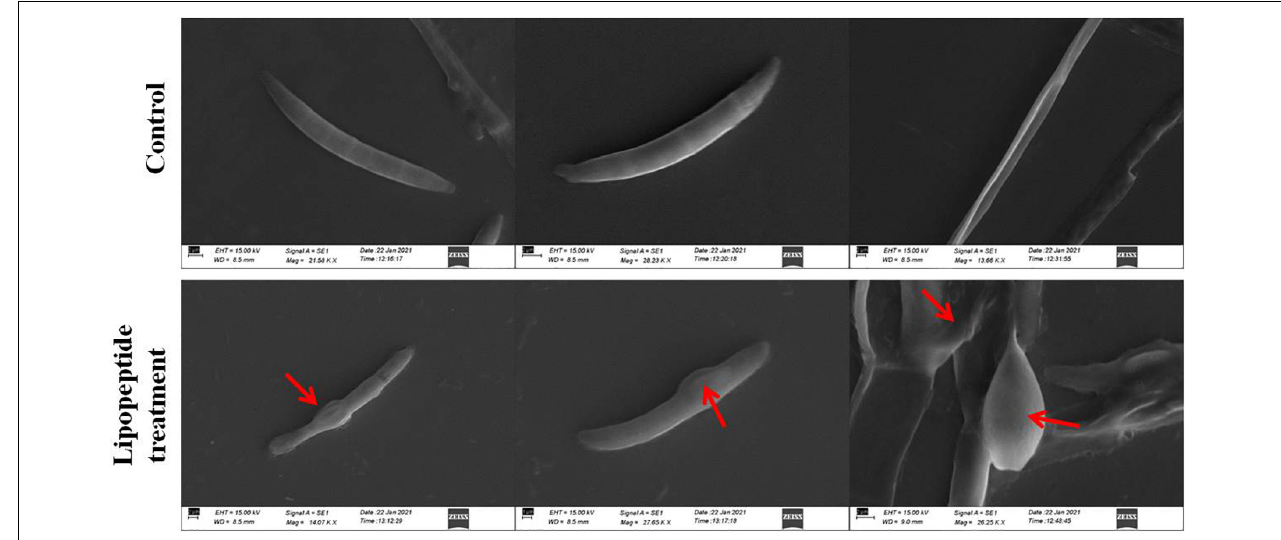
FIGURE 8 | Effects of lipopeptide on fungal hyphae and spores were observed under scanning electron microscopy (SEM). Lipopeptide treatment was done as described in Figures 6 , 7 . In control spores and hyphae were found intact and normal in structure whereas in treatment, deformation, swelling and rupturing of spores and hyphae were observed